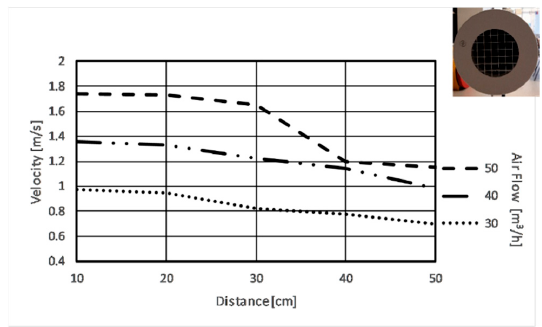
Figure 6. Mean air velocities in the case of E50/100 type ATD.